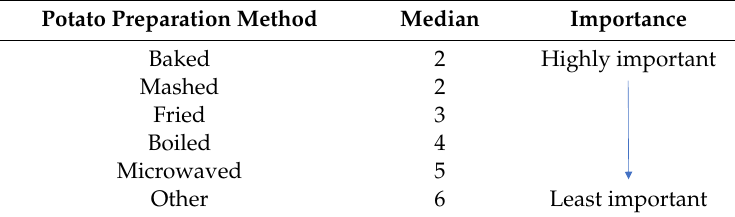
Table 3. Favorite potato preparation method Table 2. Factors influencing purchase decision ( N = 95). Factors Influencing Purchase Decision Median